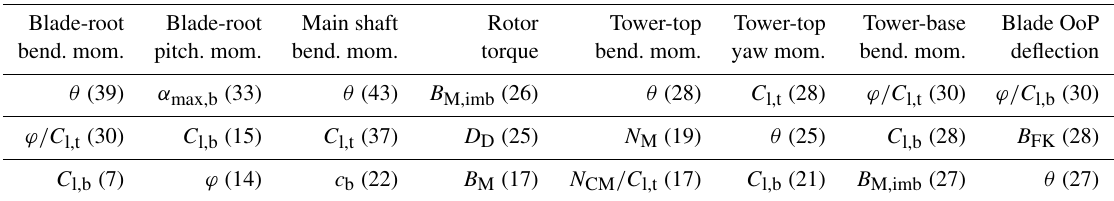
Table 12. Primary input parameters contributing to ultimate load sensitivity of each QoI. Values indicate how many times the variable contributes to the sensitivity